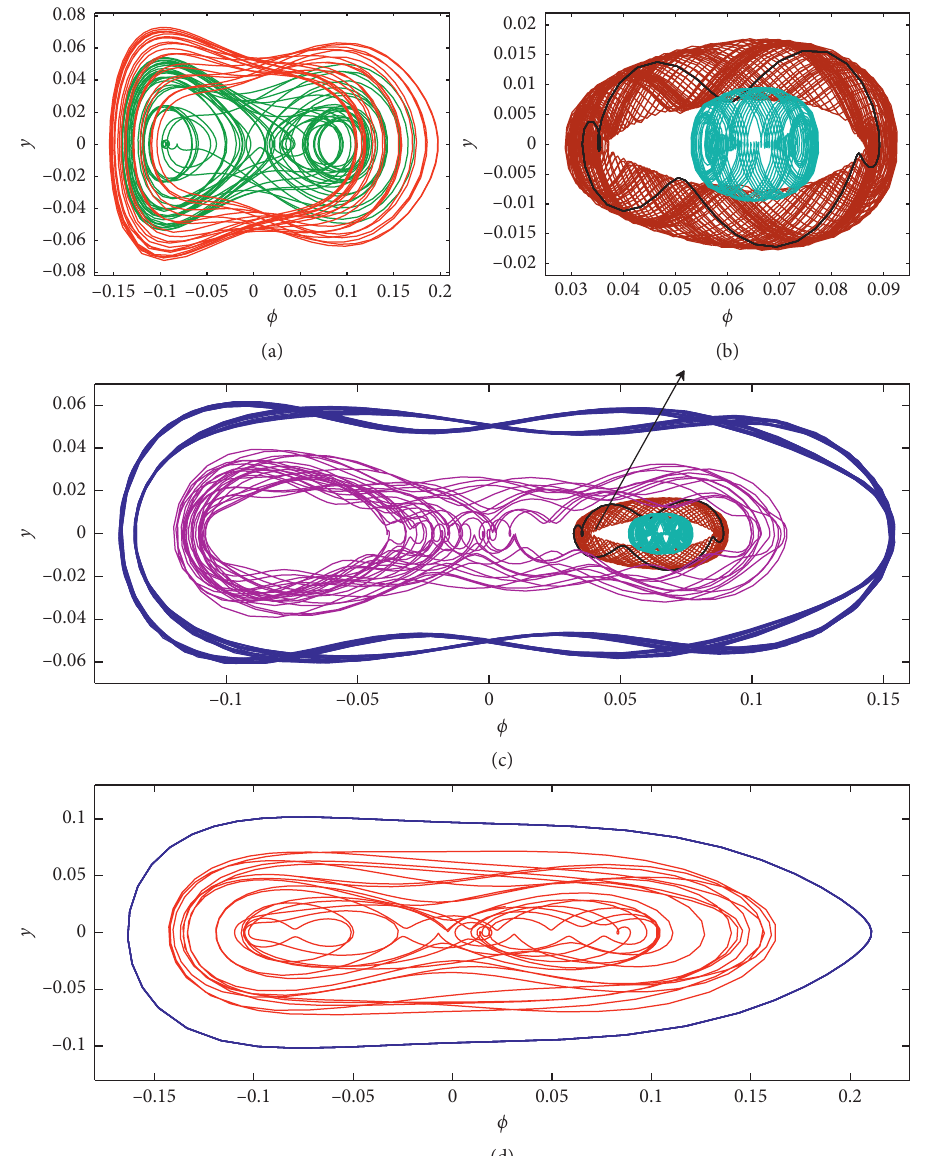
Figure 2: Coexisting attractors of system (13) for κ � 5, n � 17 . 14, μ � 1836, μ � 0 . 25187, V � 1 . 225, and f V bo pb pi ( 0 , − 0 . 00327 ) (red curve), (b) ω � 2 . 09 with intial conditions ( 0 , 0 . 011 ) (brown curve), ( 0 . 013 , 0 ) (black curve), and ( 0 . 049 , 0 ) (ocean green curve), (c) enlarged view of coexisting attractors enveloping attractors shown in Figure 2(c) with initial conditions (− 0 . 049 , − 0 . 001897 ) (magenta curve) and (− 0 . 049 , 0 . 0021 ) (blue curve), and (d) for ω � 1 . 08 with initial conditions ( 0 , − 0 . 0169 ) (red curve) and ( 0 . 21 , 0 ) (blue